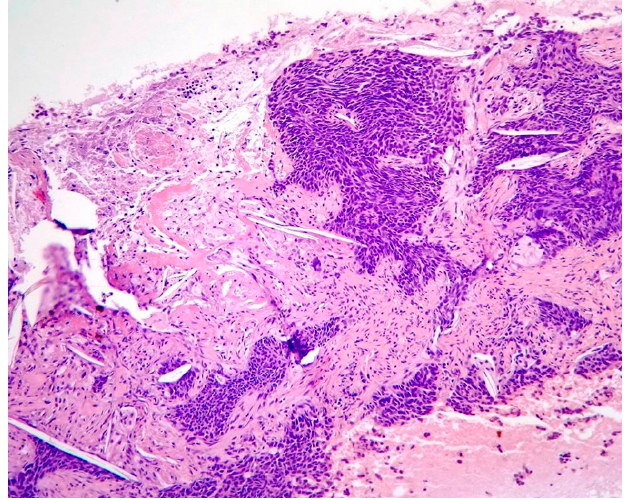
Figure 5. Small cell lung carcinoma.